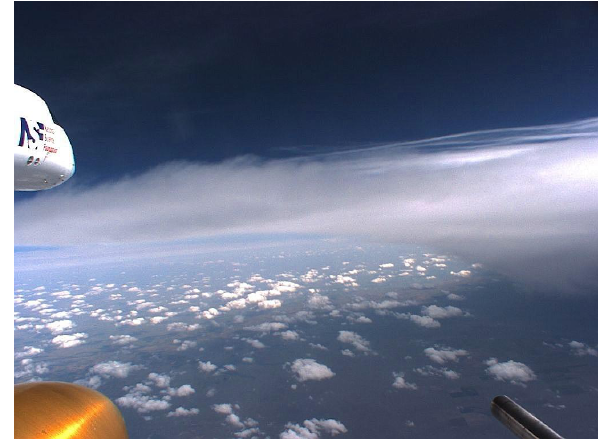
Fig. 2. Photograph of the anvil from the south storm at 22:10:56, just before sampling